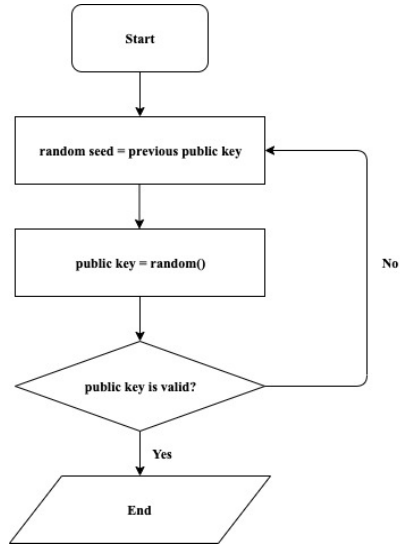
Figure 3. Algorithm to generate the public key.